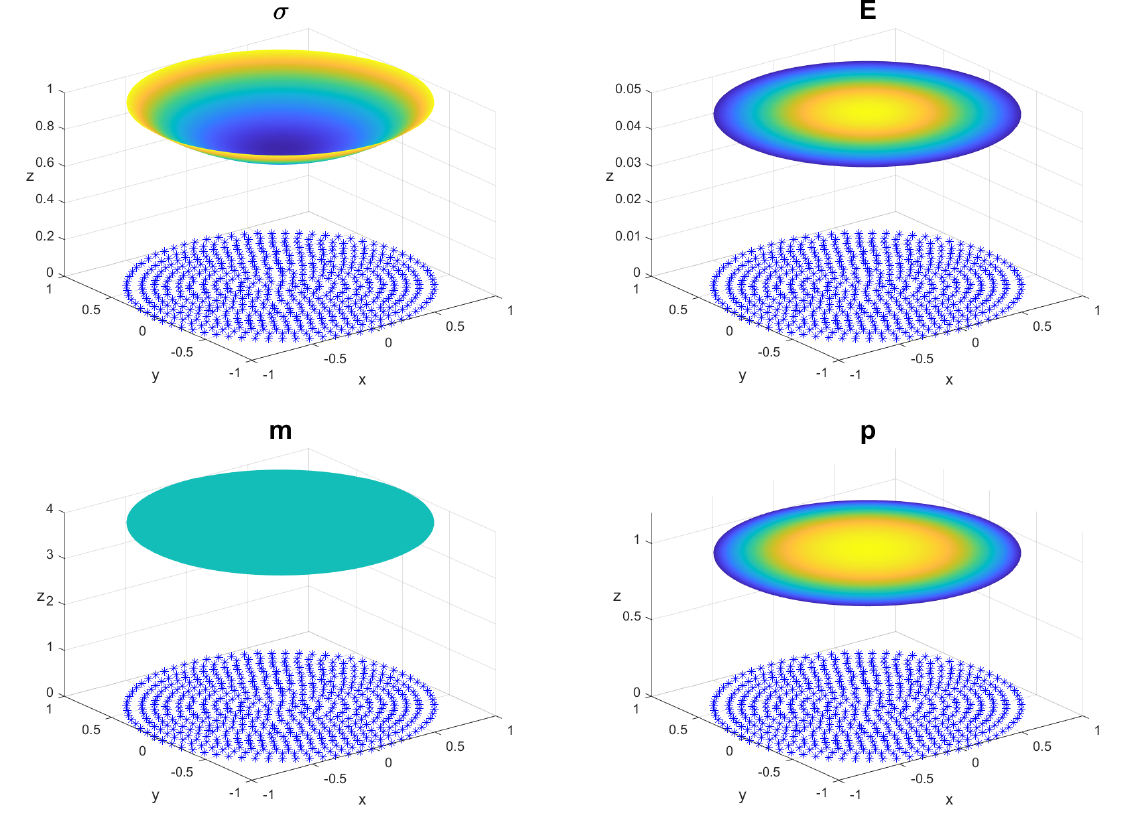
Figure 10. Graphs of the functions: σ , E , m and p for t = 10